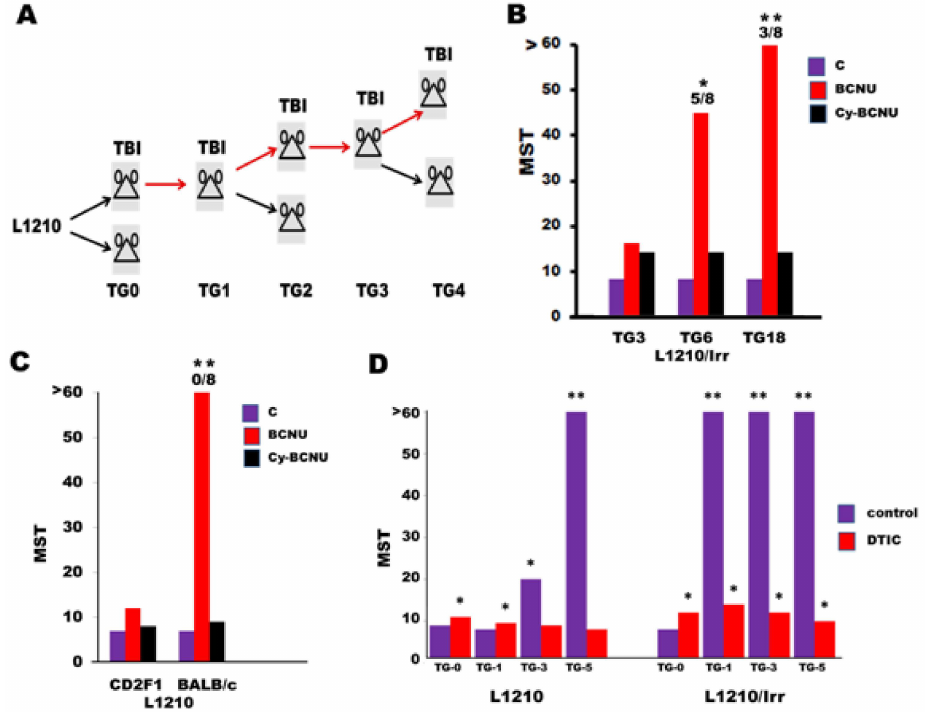
Figure 4. Radiation-induced increased immunogenicity and DIX in untreated or radioresistant mouse leukemia